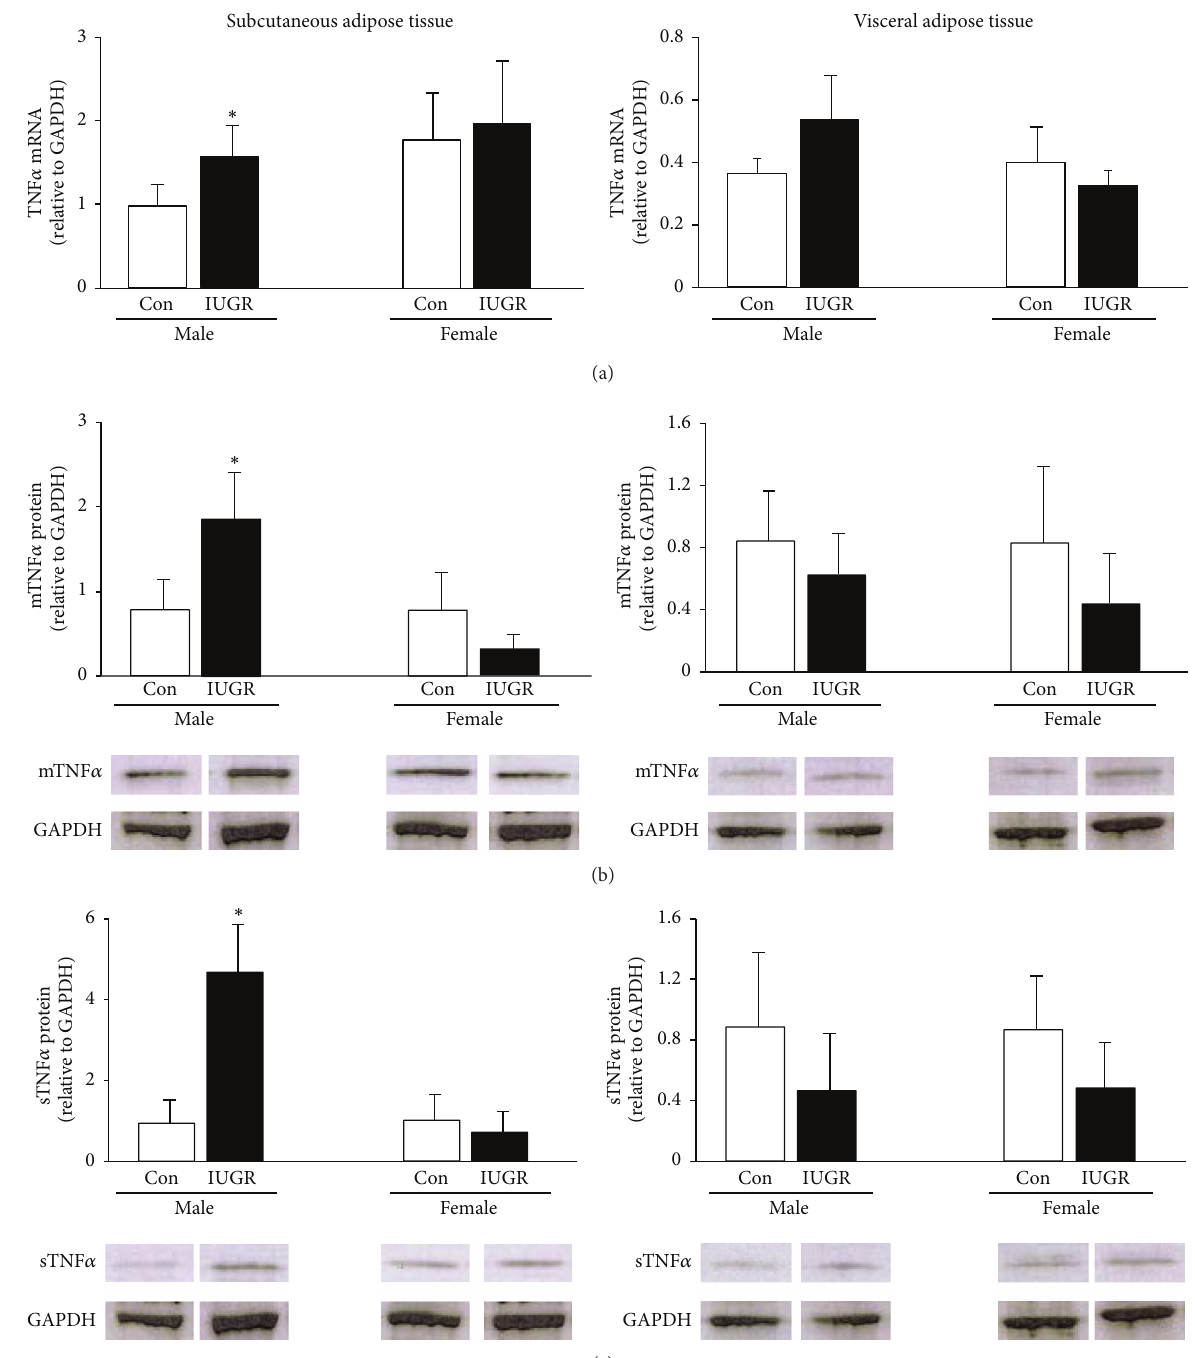
Figure 2: TNF 𝛼 mRNA and protein levels. IUGR increases subcutaneous TNF 𝛼 mRNA and protein levels in male rats. Results are control (white bars) and IUGR (black bars). Errors are SD. 𝑛 = 6 , ∗ 𝑃 ≤ 0.05 .